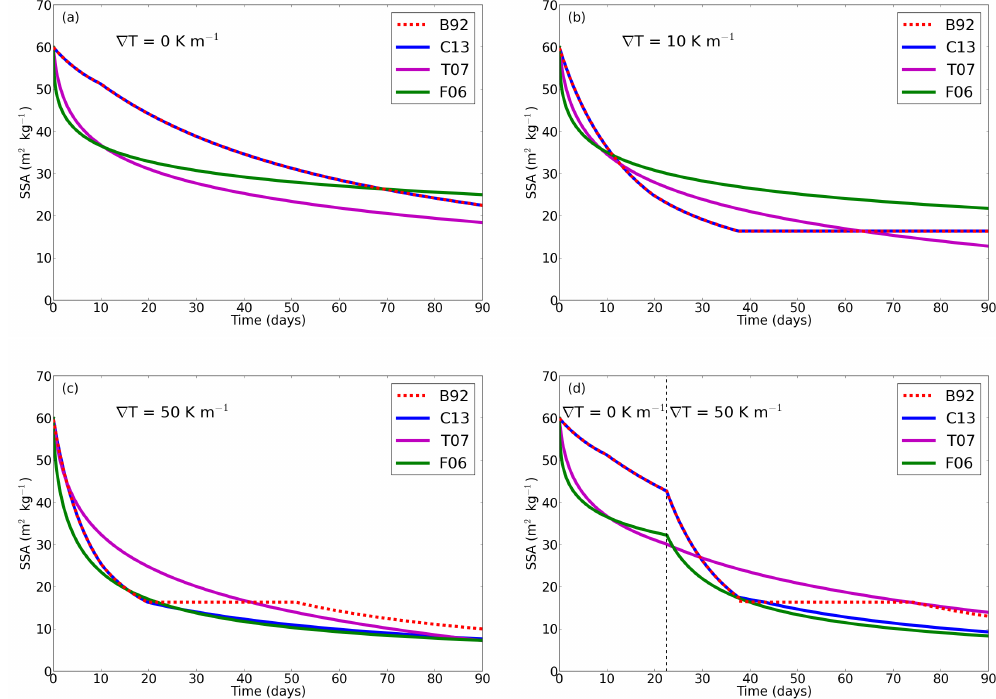
Fig. 3. Time evolution of snow SSA, according to different metamorphism formulations. B92 stands for Brun et al. (1992), T07 for Taillandier et al. (2007) and F06 for Flanner and Zender (2006), whereas C13 refers to this work. Temperature was set to − 20 ◦ C and density to 200 kg m − 3 . The four panels correspond to different temperature gradient values.